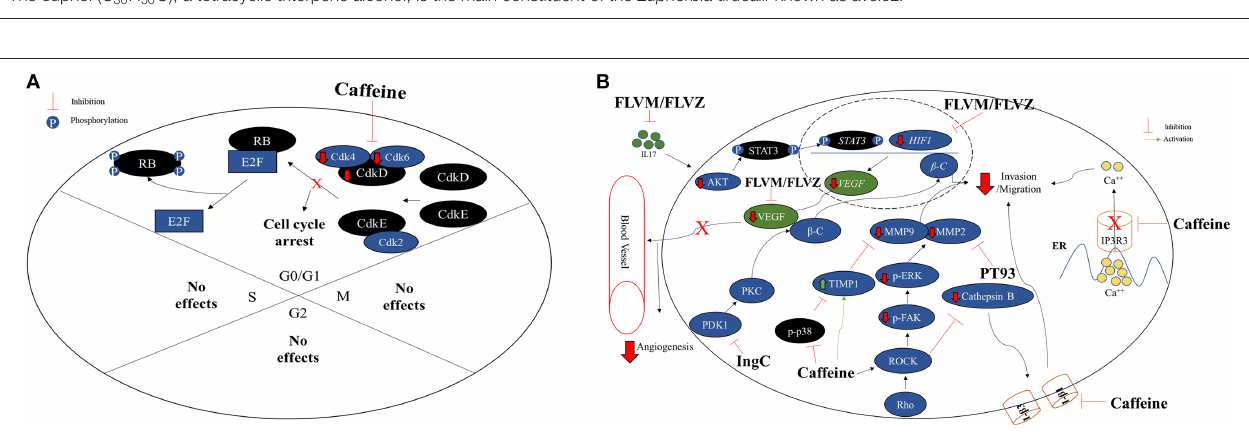
( Figure 2B ). PT93, a selective MMP inhibitor, seems to present fewer side effects when compared to the first generation of MMP